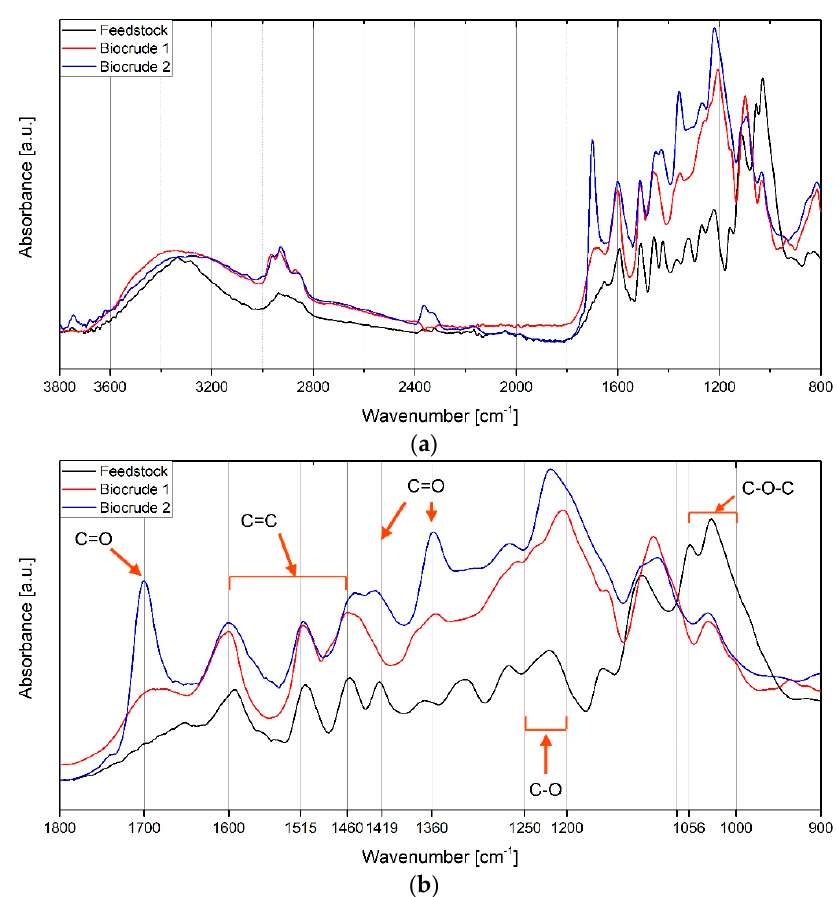
Figure 12. Infrared spectra of the LRS and light and heavy fraction of biocrude from the experiment carried out at 370 °C, 5 min, 20%: ( a ) entire spectra; ( b ) particular.